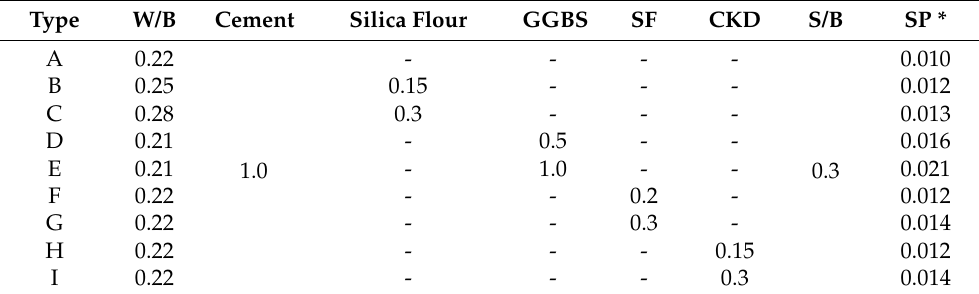
Table 2. Mixture proportions of ultra-high-performance, strain-hardening cementitious